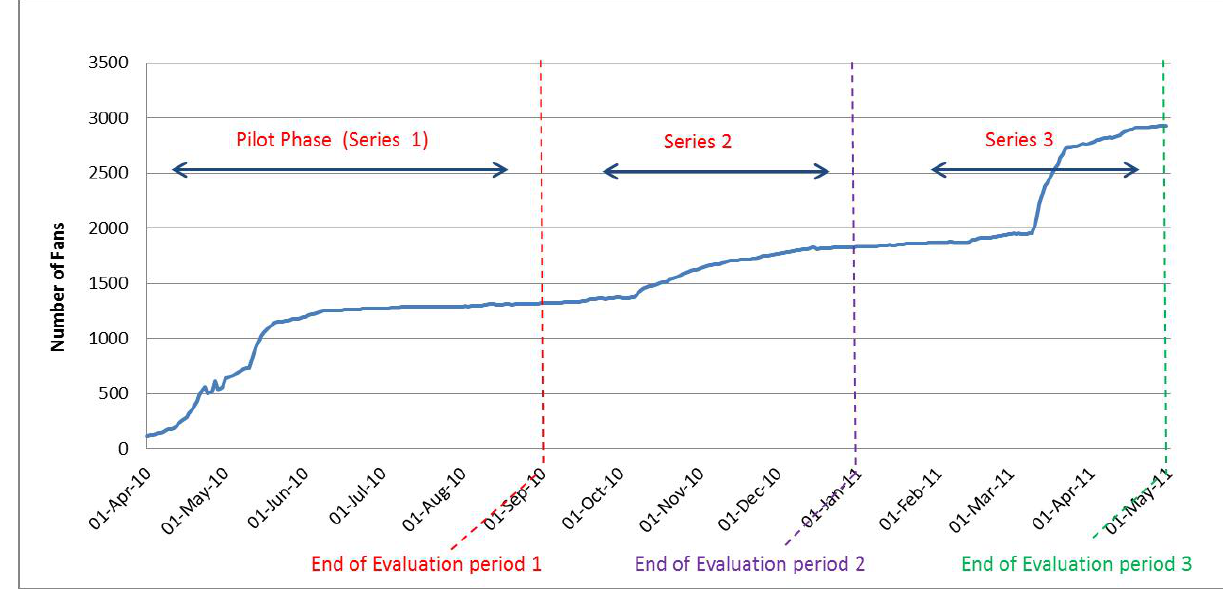
Figure 3. Total fans over time, on QAF Facebook page from Series